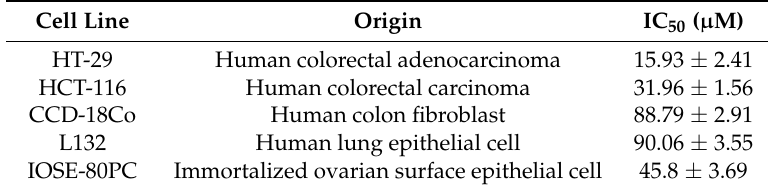
Figure 1. Effect of KSK05104 on the growth inhibition in colon cancer cells. ( A ) Chemical structure of KSK05104; ( B ) Cell viability of KSK05104 in HT-29 and HCT-116 cells. Cells were treated with KSK05104 for the indicated times. Data are the means ± S.D. of the results from three independent experiments. * p < 0.05, *** p < 0.001 vs. non-treated control group. Table 1. The cytotoxic activity of KSK05104 assessed by MTT assay on cell growth in vitro .